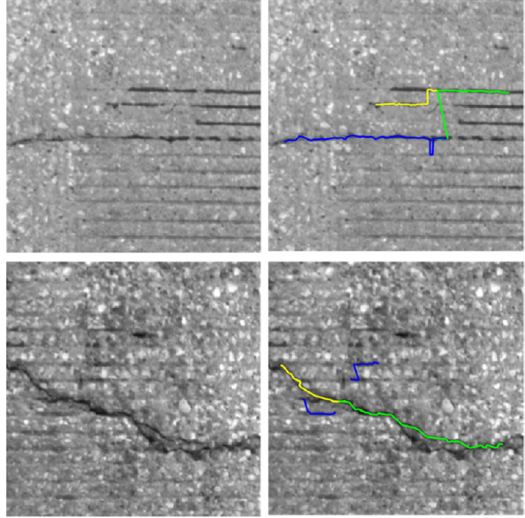
Figure 17. Examples of cases that did not indicate the crack properly.